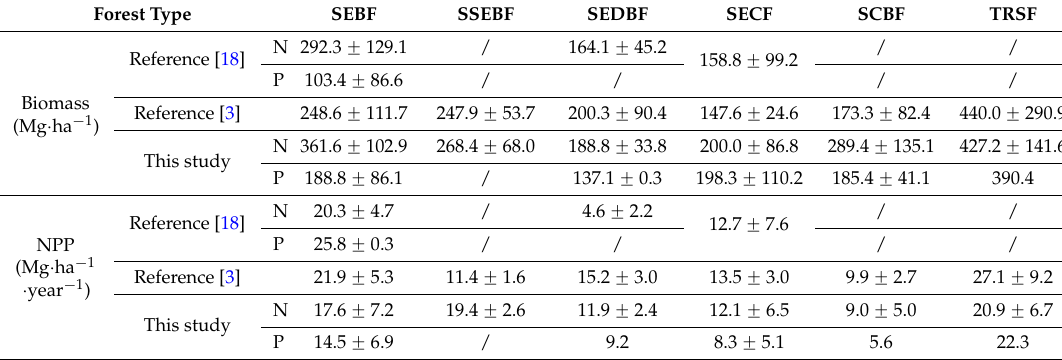
Table 2. Summary of forest biomass and NPP in Southwestern China. The present study and those of reference [18] obtained data from field observations; reference [3] obtained data from both forest inventory and field observations. N: natural forests; P: planted forests. All abbreviations of forest types can be found in Table